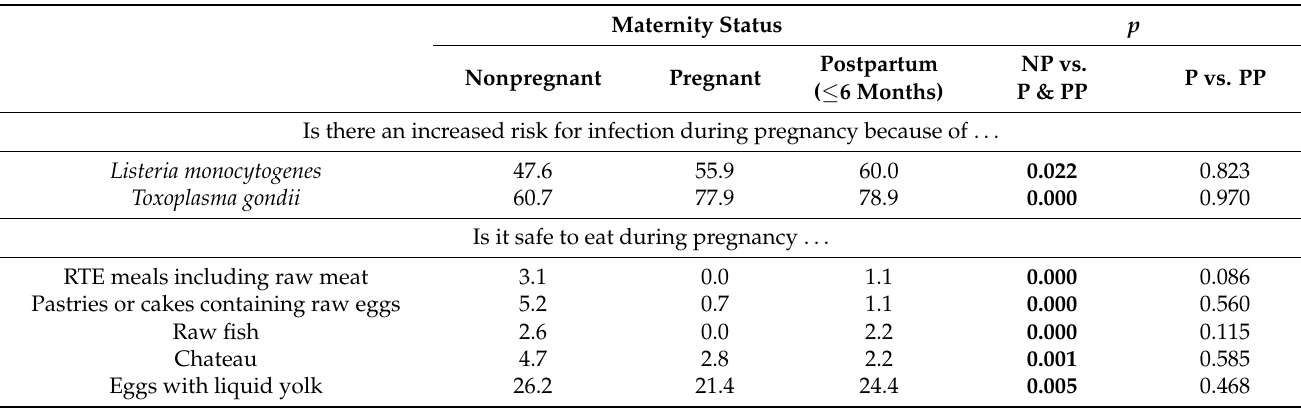
Table 2. Agreement rate (%) when considering the risk of infection by specific microorganisms or foods during pregnancy by maternity